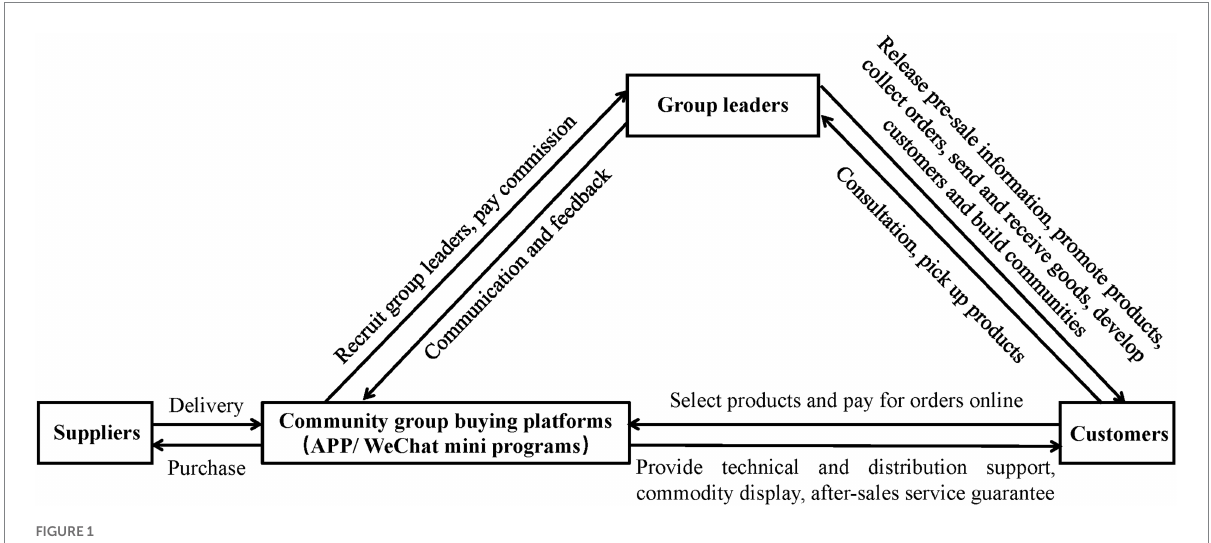
FIGURE 1 Operation process of community group